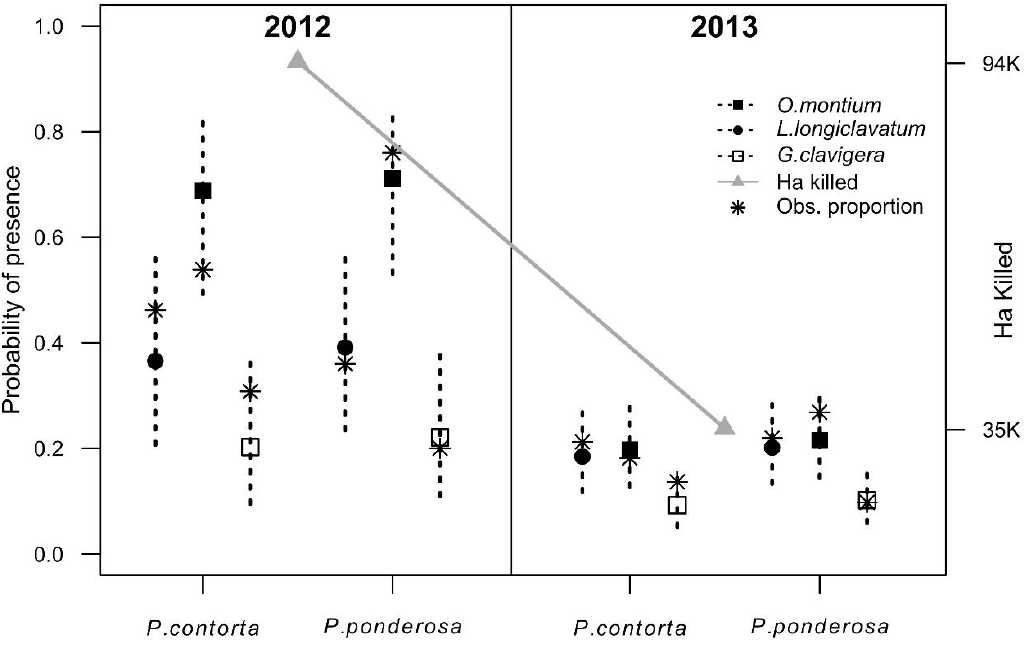
Figure 4. The probability of blue-stain fungal species being transported by mountain pine beetles during the two years. A decrease in the probability of presence occurred in 2013 and was parallel to a reduction in the measured beetle activity (Hectares killed) at Larimer County, CO. The asterisks indicate observed frequencies.